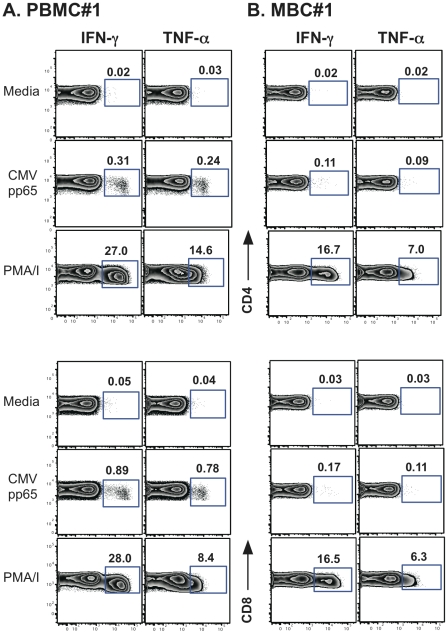
CMV-specific T cells derived from the menstrual blood.
A. PBMC B. MBC from the same healthy woman (#1). Cells were stimulated with overlapping peptides from CMV pp65 and PMA/I as a positive control. Both IFN-γ and TNF-α secretion are shown. Percent of cytokine positive cells (IFN-γ or TNF-α) are shown above the gate.